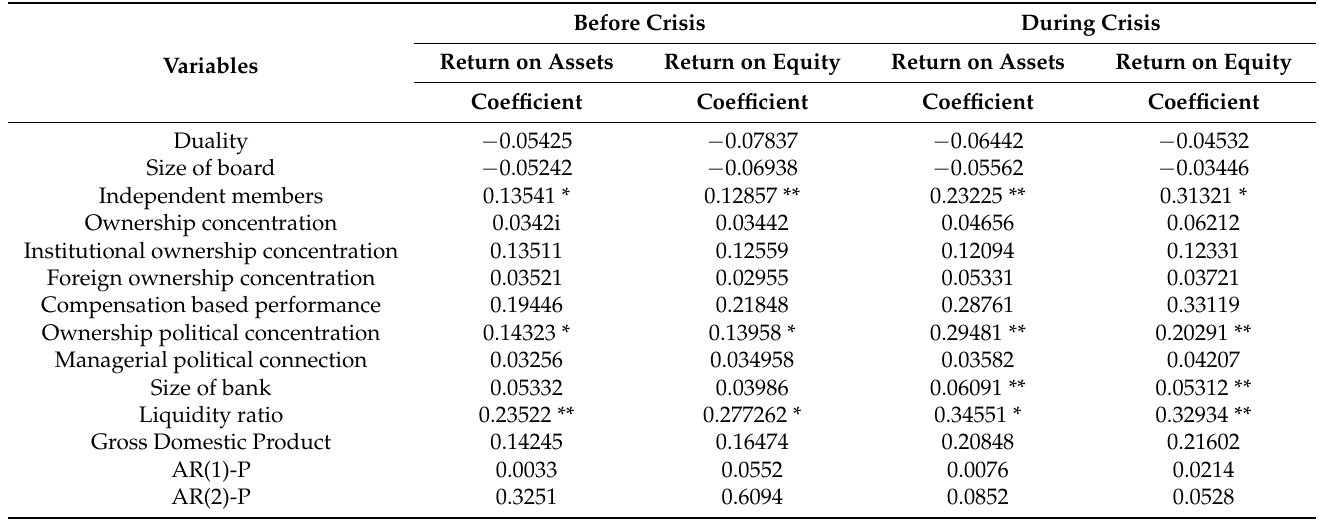
Table 6. GMM Regressions of ROA and ROE on Corporate Governance Variables and